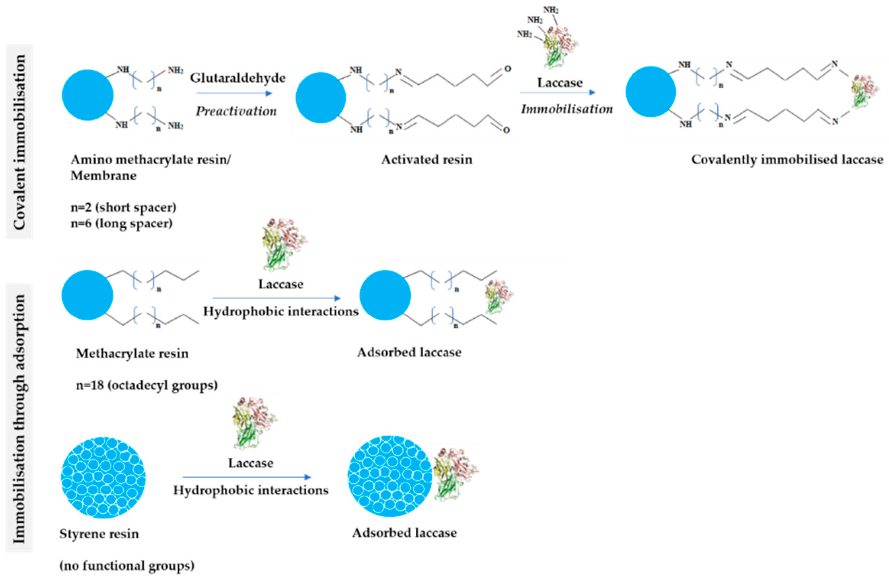
Figure 2. Schematic structure of tested carriers and the mechanism of laccase immobilisation covalently and through adsorption.